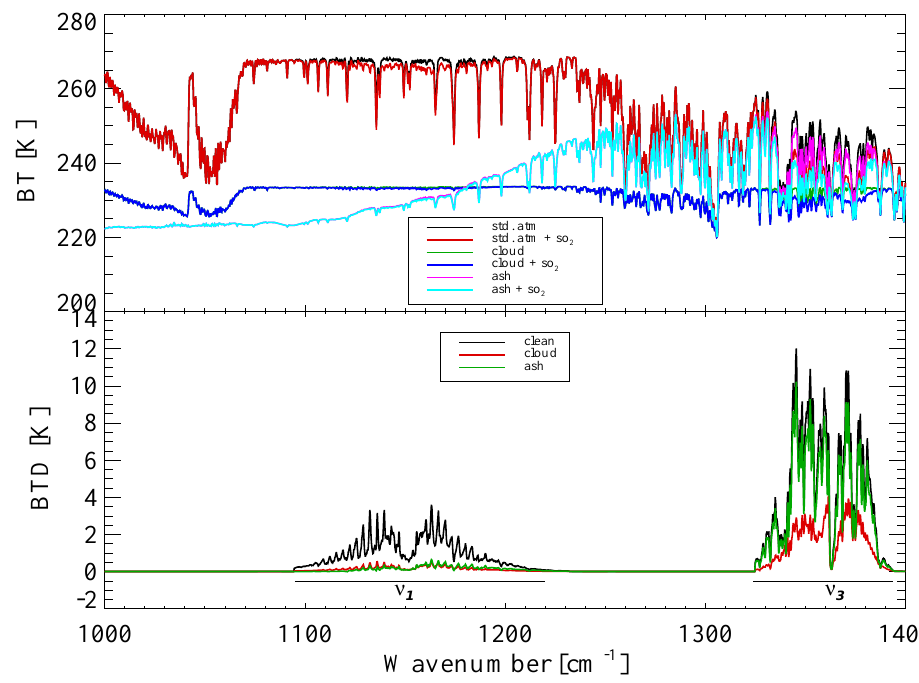
Fig. 5. The top plot shows simulated IASI spectra for (a) the clear reference atmosphere (black line), (b) the clear reference atmosphere with the addition of SO 2 plume (red), (c) the clear reference atmosphere with the addition of a water cloud (green), the clear reference atmosphere with the addition of a water cloud and SO 2 plume (blue), the clear reference atmosphere with the addition of an ash layer (pink); the clear reference atmosphere with the addition of an ash layer and SO 2 plume (cyan). The water cloud had an effective radius of 20µm, an optical depth of 10 at 550nm and an altitude of 400mb. The ash layer had an effective radius of 2µm, an optical depth of 3 at 550nm, and an altitude of 400mb. The SO 2 plume had a Gaussian profile with a column amount of 50DU, a maximum concentration at 400mb ( ∼ 6 . 4km) and a vertical spread of 100mb. The bottom plot shows the brightness temperature difference between IASI spectra simulated for clear, cloud and ash laden with and without an SO 2